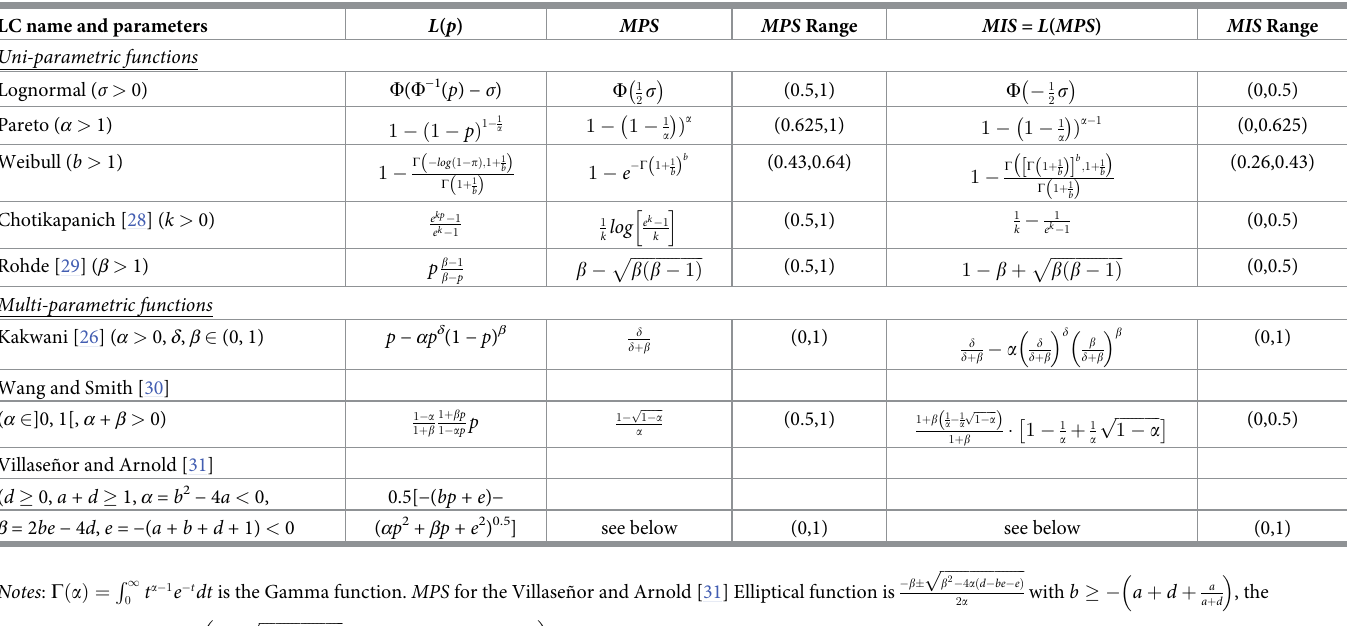
Table 3. MPS and MIS for widely-used Lorenz